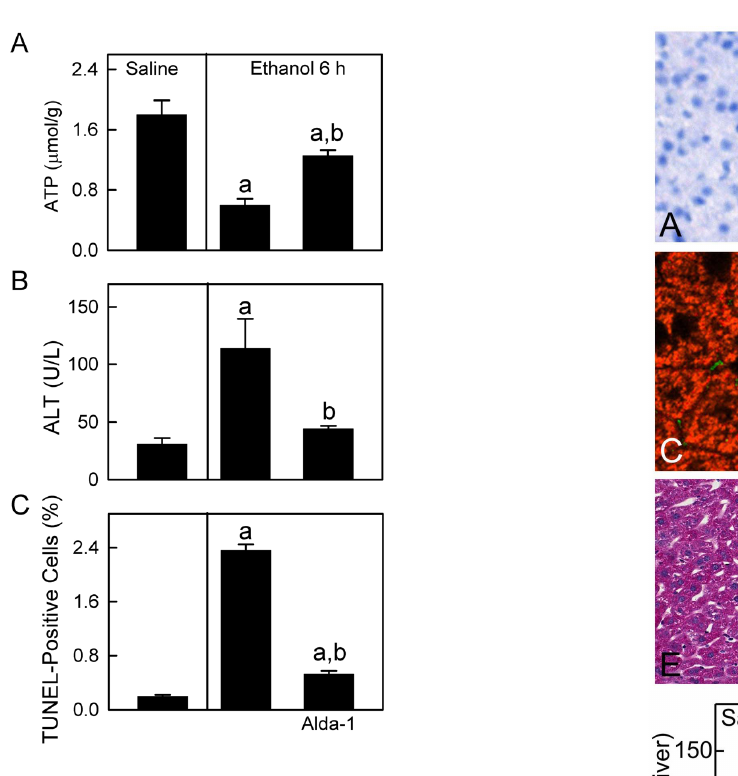
Figure 10. Ethanol decreases hepatic ATP and causes modest liver injury: protection by Alda-1. Mice were injected with vehicle or Alda-1 (50 mg/kg, i.p. ) 30 min before gavage of saline or ethanol (6 g/kg), and blood and livers were collected 6 h later for hepatic ATP ( A ), serum ALT ( B ) and TUNEL ( C ) measurement. TUNEL-positive cells in liver sections were counted in 10 random fields. Values are means 6 SEM (n=4 per group). a, p , 0.05 vs saline; b, p , 0.05 vs ethanol without Alda-1.